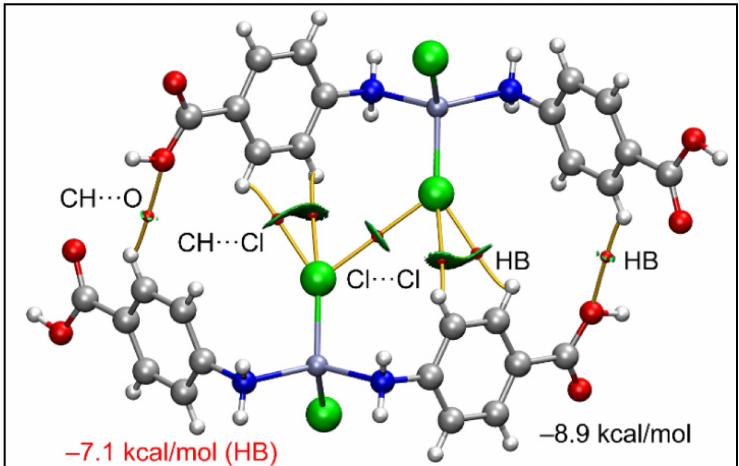
Figure 10. QTAIM (bond paths in orange and bond CPs in red) and RDG surfaces of the model dimeric assembly of compound 1 ; the gradient cut-off is (cid:36) = 0.04 a.u., s = 0.35, and the color scale is − 0.04 a.u. < (cid:36) < 0.04 a.u. Only intermolecular interactions are represented. The total contribution of the H-bonds is also indicated, estimated using the Vr energy